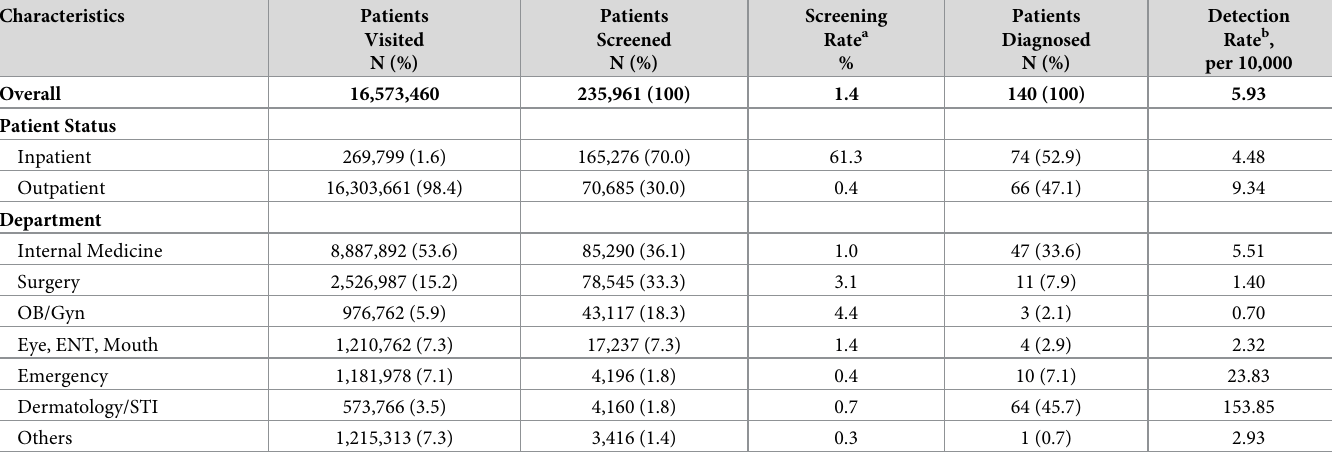
Table 1. HIV screening and detection rates at Xuanwu Hospital, Beijing, China,